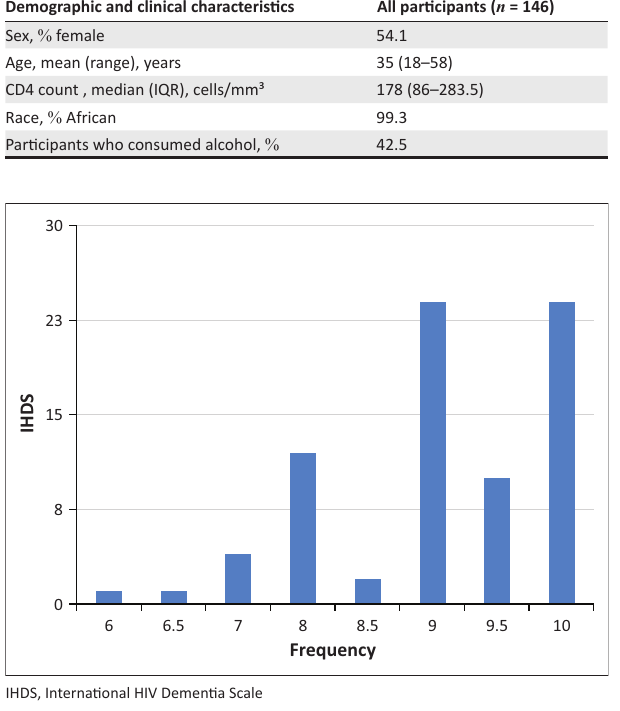
FIGURE 2: Distribution of International HIV Dementia Scale (IHDS) score among participants with HIV-associated neurocognitive disorder (HAND). The y-axis